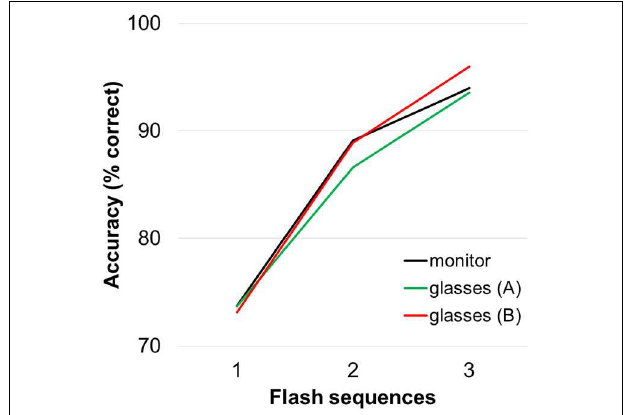
FIGURE 2 | Average accuracies for the three display methods. Accuracies were calculated offline (for three flash sequences the values are equal to those achieved during online spelling).